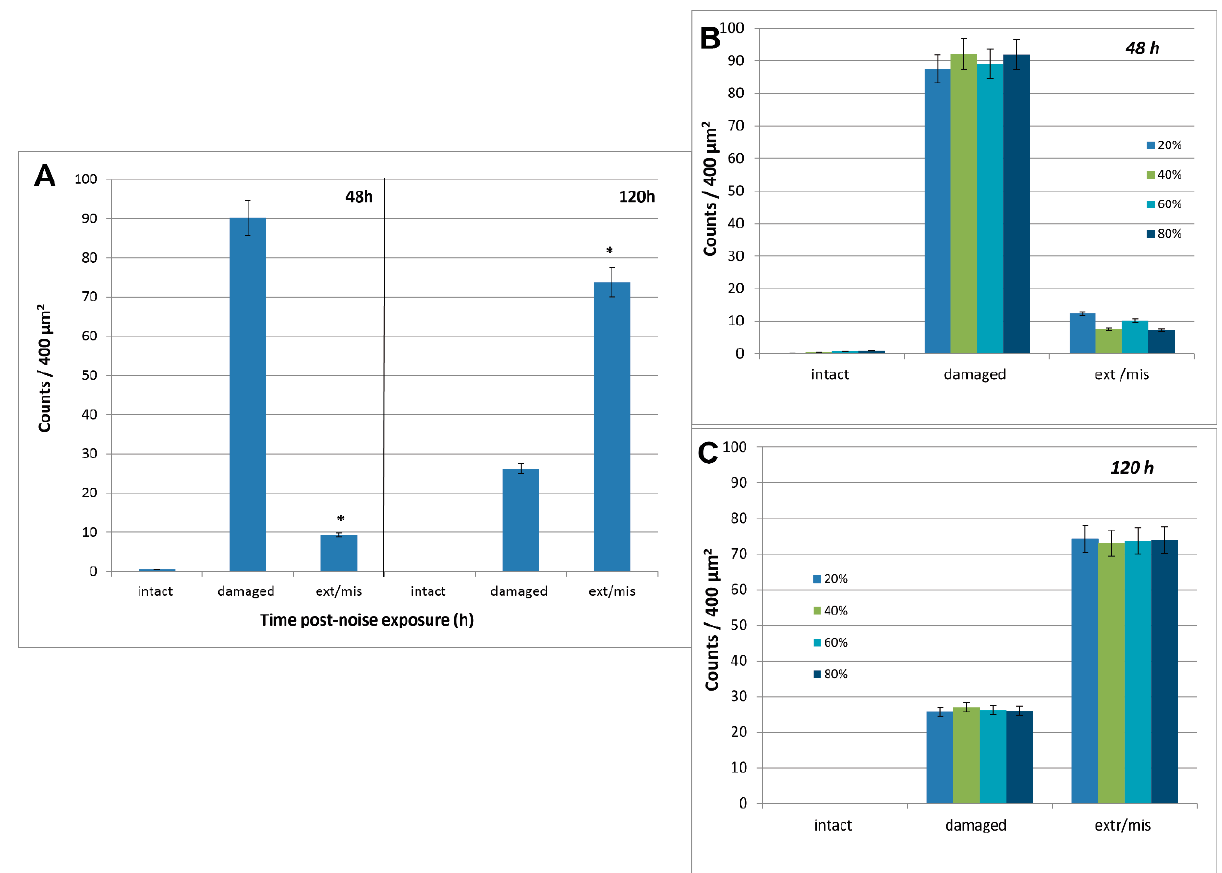
Figure 8 . (A): Mean (±SE) intact, damaged, extruded/missing hair cells over the total length of sensory epithelium on P. maculata statocyst (48 h versus 120 h after sound exposure). The lesion severity was found to be significantly higher at 120 h than at 48 h ( p = 9.99 × 10 − 4 ; n = 40). (* significant difference). ( B) : Hair cell counts between the different regions in animals 48 h after sound exposure. The lesion severity was found to be similar between 40%, 60%, and 80% regions ( p = 0.91; n = 40; see text for 20% region consideration). ( C ) : Hair cell count between the different regions in animals 120 h after sound exposure. Each bar is the average over the 4 regions with the line indicating the standard error. The percentage was computed by dividing with the total count for each individual sample. The lesion severity was found to be similar between all regions ( p = 0.73; n = 40).